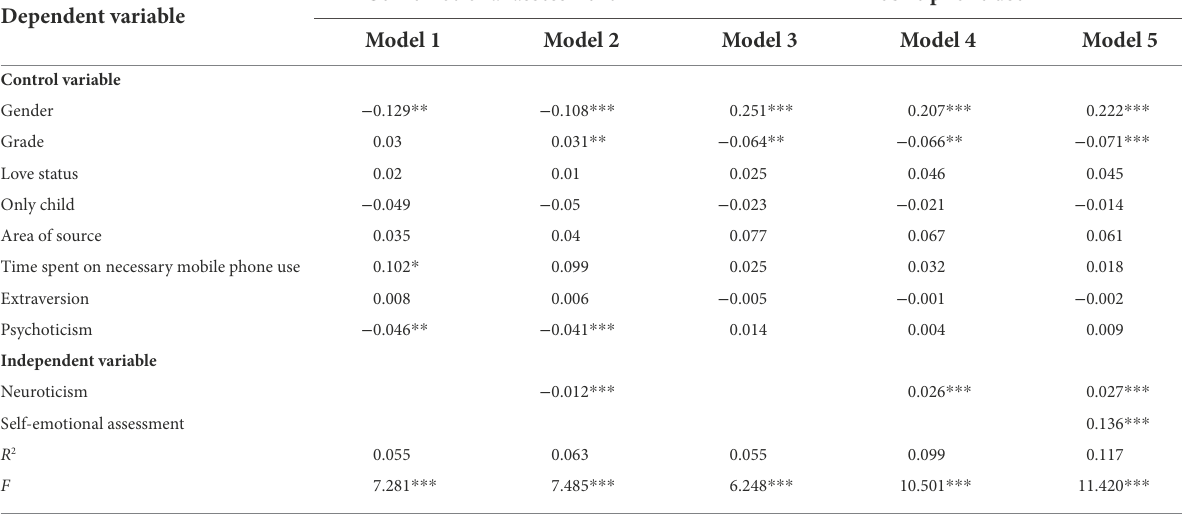
TABLE 2 Hierarchical regression analysis with control variables.